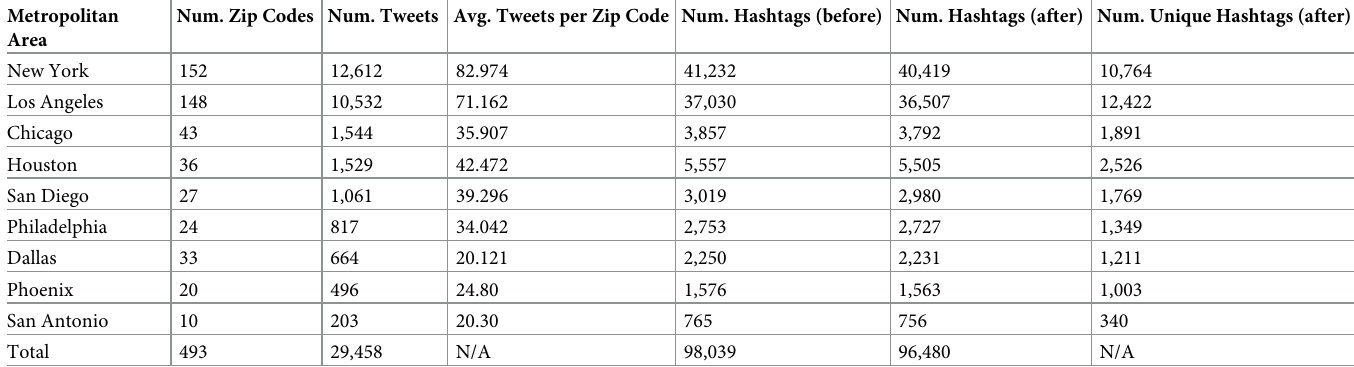
Table 1. A summary of key dataset statistics per metropolitan area. Hashtag counts are reported both before, and after, the text preprocessing steps. Metropolitan